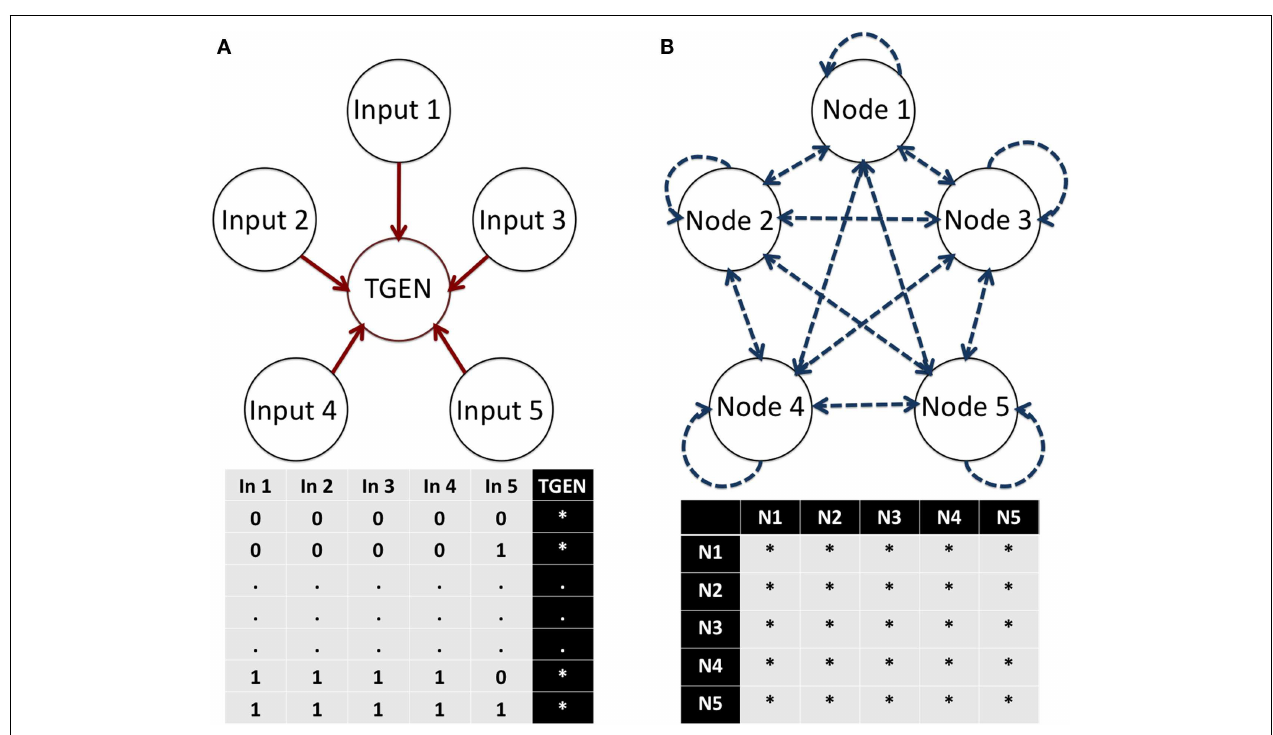
of possible topologies of a network depends on the number of nodes. In a network, each node can interact with itself and any other node.Thus, n 2 possible interactions exist. Because each interaction can either exist or not exist, 2 n 2 possible topologies describe a network with N nodes. E, Exist, and D, Do not